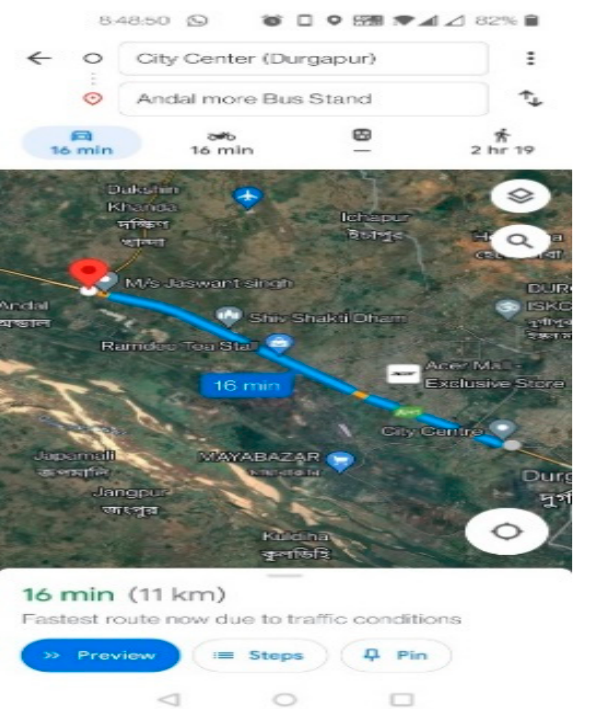
Figure 6. Semidirected network of a road network system. Table 5. Description of node.